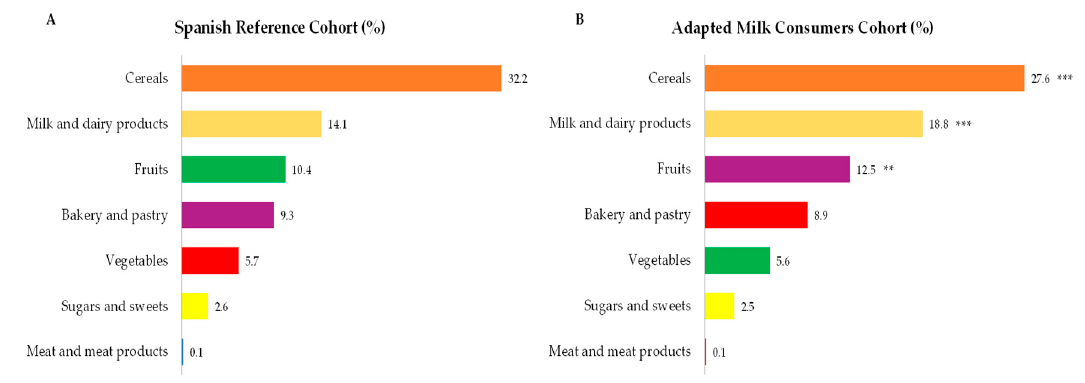
Figure 2. Dietary food and beverage groups contributing to total carbohydrate intakes (%) from the EsNuPI study population (“Spanish Pediatric Population”) in both Spanish Reference Cohort ( A ) and the Adapted Milk Consumers Cohort ( B ). ** p ≤ 0.01 compared to reference cohort (Mann-Whitney test). *** p ≤ 0.001 compared to reference cohort (Mann-Whitney test). Only foods contributing ≥ 0.1% to total carbohydrates intakes of the population have been included.